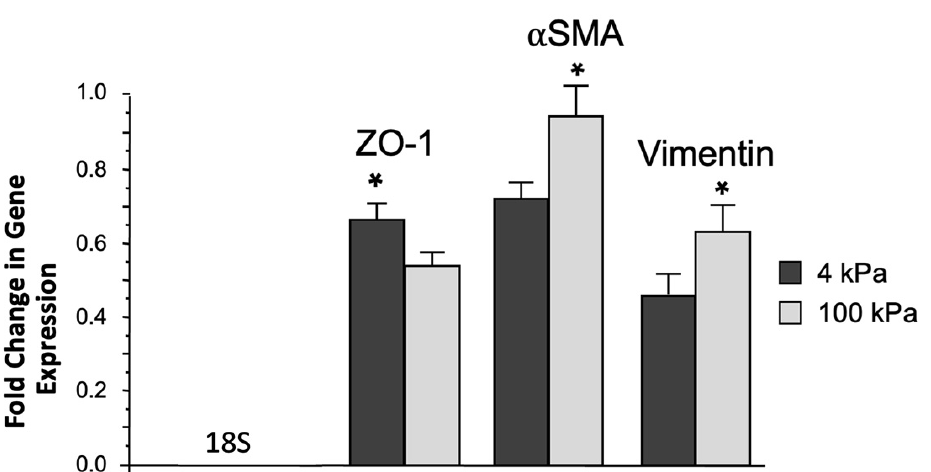
Figure 3. Effect of a stiff substrate on EMT-related gene expression in ARPE-19 cells. Fold change